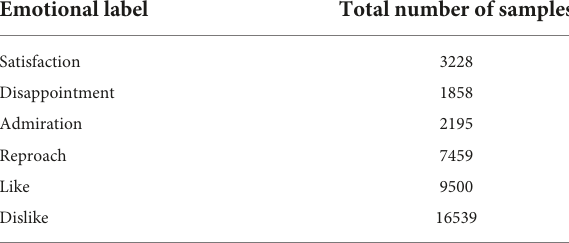
TABLE 2 Distribution of auxiliary emotional